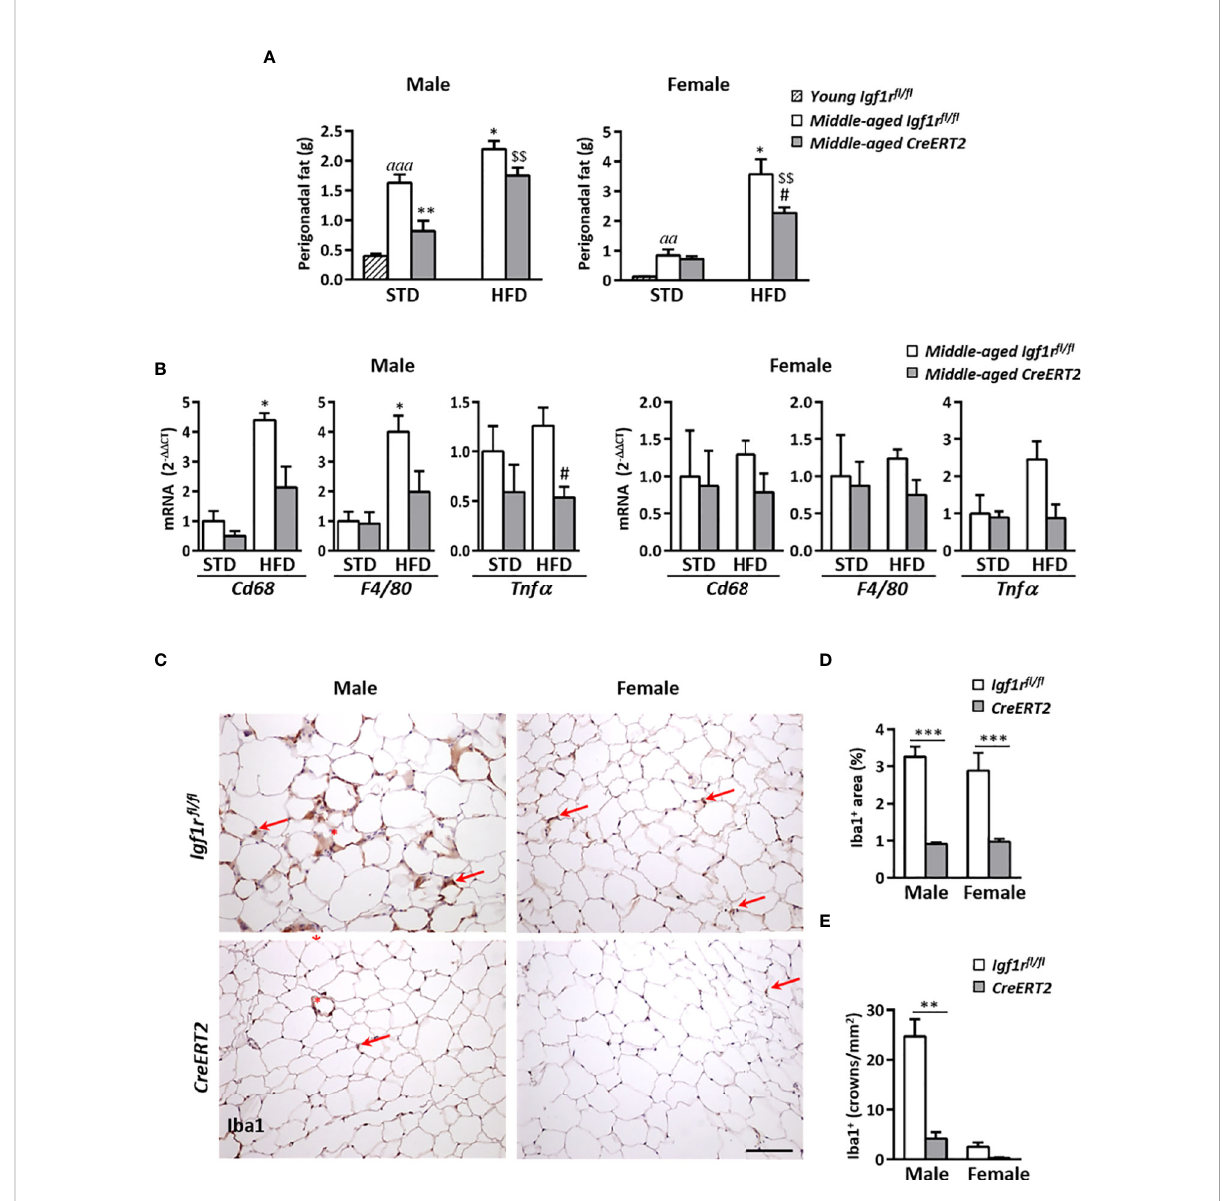
FIGURE 8 Effects of IGF1R de fi ciency on perigonadal adipose tissue content and in fl ammation in middle-aged mice on HFD diet. (A) Effects of IGF1R depletion on perigonadal fat weight in male and female mice fed with either STD or HFD compared to young control ( Igf1r fl / fl ) male and females on STD (n= 4-10 mice per group). (B) mRNA levels of in fl ammatory markers Cd68 , F4/80 and Tnf a mRNA levels in midlle-aged mice fed either with STD or HFD. Gene expression is expressed as fold changes (2 - DD Ct ) compared to its Igf1r fl / fl corresponding control group. Data are expressed as mean ± SEM of at least 4 animals per group. (C) Representative immunohistochemical stainings of perigonadal fat tissue for the speci fi c macrophage marker Iba1 (red arrows) in middle-aged mice fed with HFD. Crown-like structures, composed of macrophages surrounding adipocytes, are indicated with red asterisks. Scale bar: 100 µm. (D) Graphical representation of Iba + stained area quanti fi cation (percentage) shown in (C) . (E) Quanti fi cation of crown-like Iba1 + structures (density). Data in (D, E) are expressed as mean ± SEM of 2-10 animals per group (data obtained per animal analyzed in duplicated sections). aa p < 0.01 and aaa p < 0.001 vs . young Igf1r fl / fl mice; *p < 0.05 and **p < 0.01 vs . middle-aged Igf1r fl / fl STD animals; # p < 0.05 vs. middle-aged Igf1r fl / fl HFD middle-aged mice; and $$ p < 0.01 vs. middle-aged CreERT2 STD animals in (A, B) **p < 0.01 and ***p < 0.001 vs . corresponding Igf1r fl / fl mice, in (D, E)